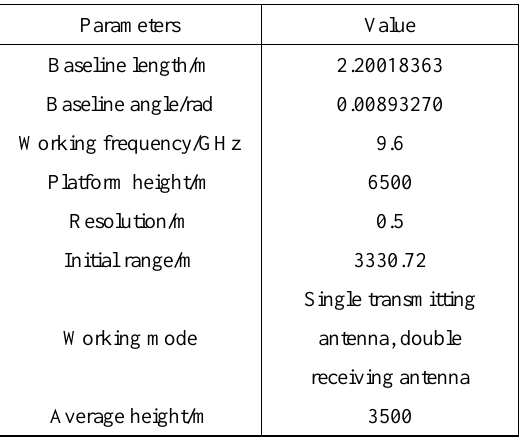
Table 1. Aircraft system parameters